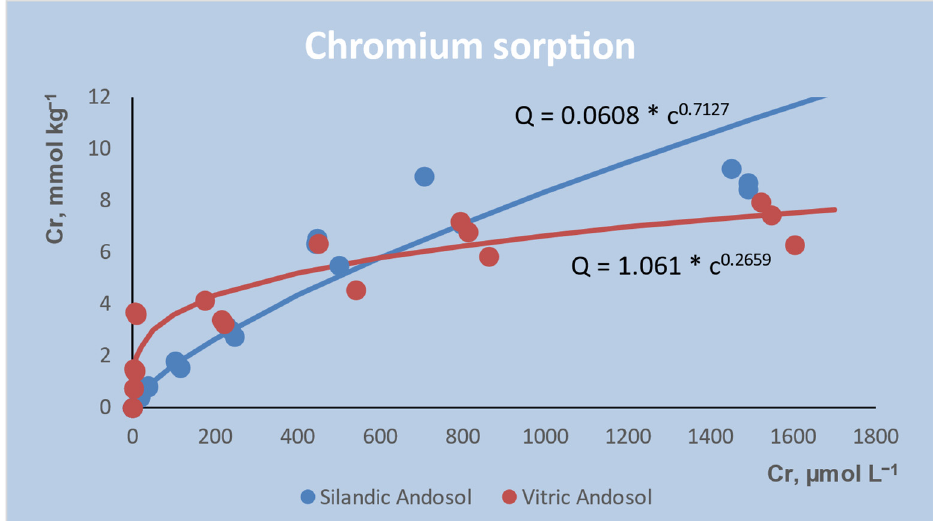
Figure 6. Cr sorption isotherms (sorbed Cr (mmol kg − 1 ) vs. Cr concentration in the equilibrium solution (µmol L − 1 )) fitted to the Freundlich model.